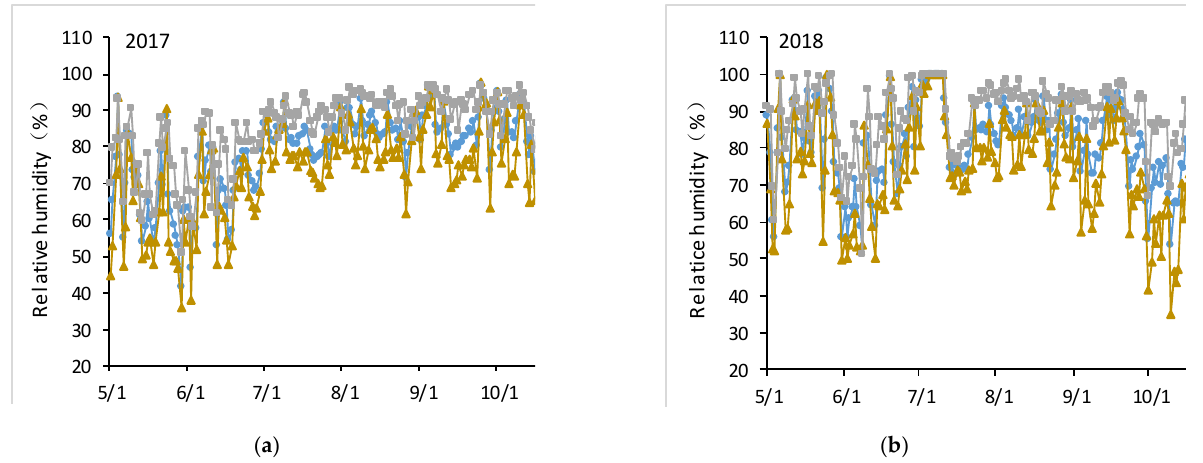
Figure 4. Variation of relative humidity during rice growing season. MRH, mean relative humidity; DH, daytime relative humidity; NH, night relative humidity. ( a ): 2017; ( b ): 2018.